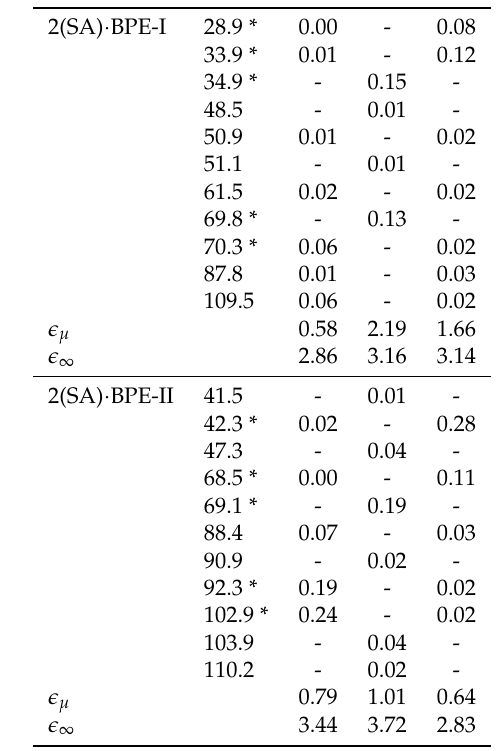
Table 9. Same description as Table 8, but for 2(SA) · BPE polymorphs I (top) and II (bottom) using DFT-D. Asterisks are next to the frequencies that have high contributions to (cid:101) µ and are plotted in Figures 12 and 13 for 2(SA) · BPE polymorphs I and II, respectively.